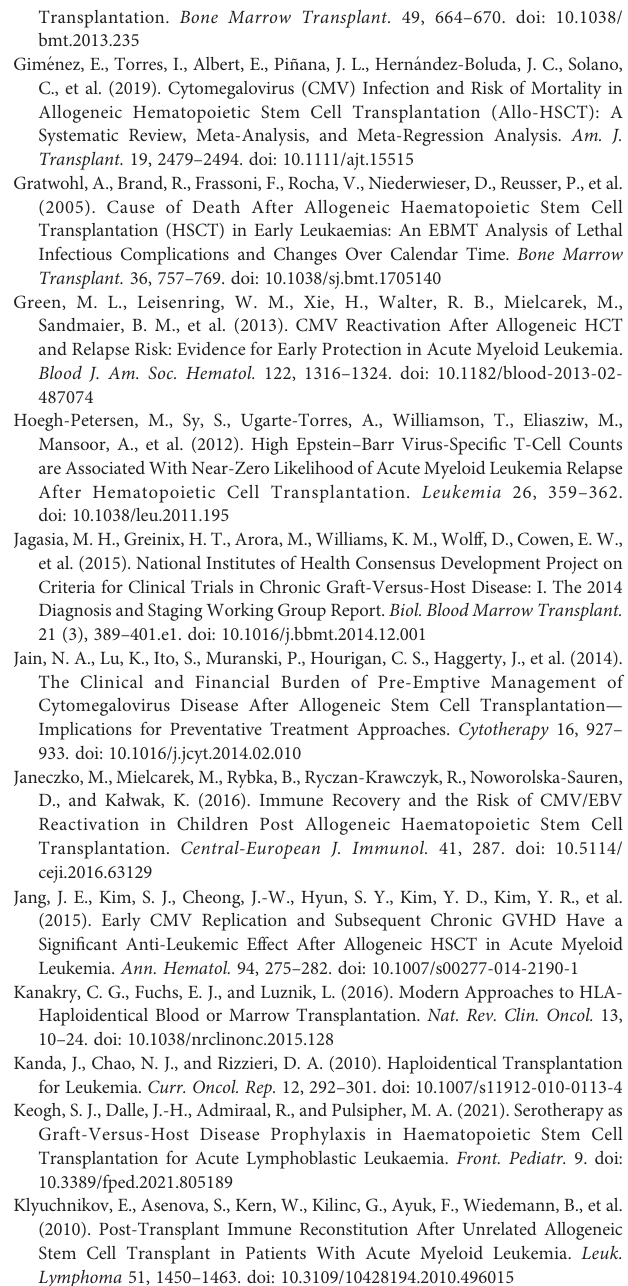
Supplementary Figure 1 | Transplant outcomes between AML and ALL patients in the whole cohort. (A) OS between AML and ALL patients in the whole cohort. (B) PFS between AML and ALL patients in the whole cohort. (C) TRM between AML and ALL patients in the whole cohort. (D) CIR between AML and ALL patients in the whole